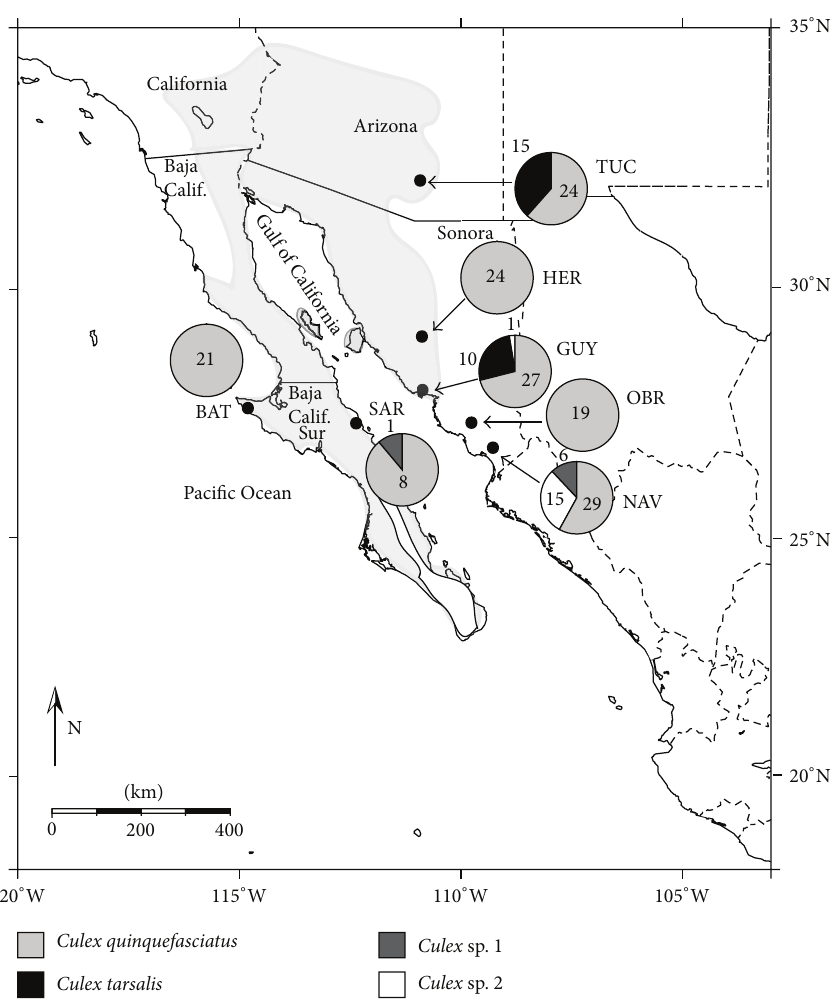
Figure 1: Map showing collection localities for Culex spp. in northwestern Mexico and southern Arizona, USA. Light gray shading on map shows approximate boundaries of the Sonoran Desert. Pie charts show numbers of individuals of each species analyzed from each locality. TUC: Tucson; HER: Hermosillo; GUY: Guaymas; OBR: Ciudad Obreg´on; NAV: Navojoa; SAR: Santa Rosal´ıa; BAT: Bah´ıa Tortugas.